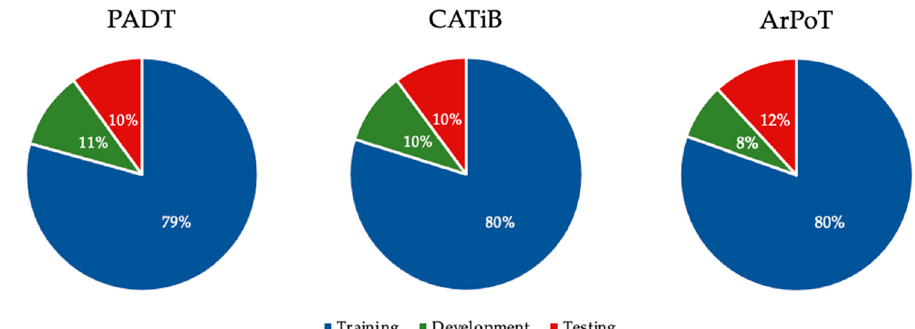
Figure 2. Data split into training, development, and testing for each dataset.